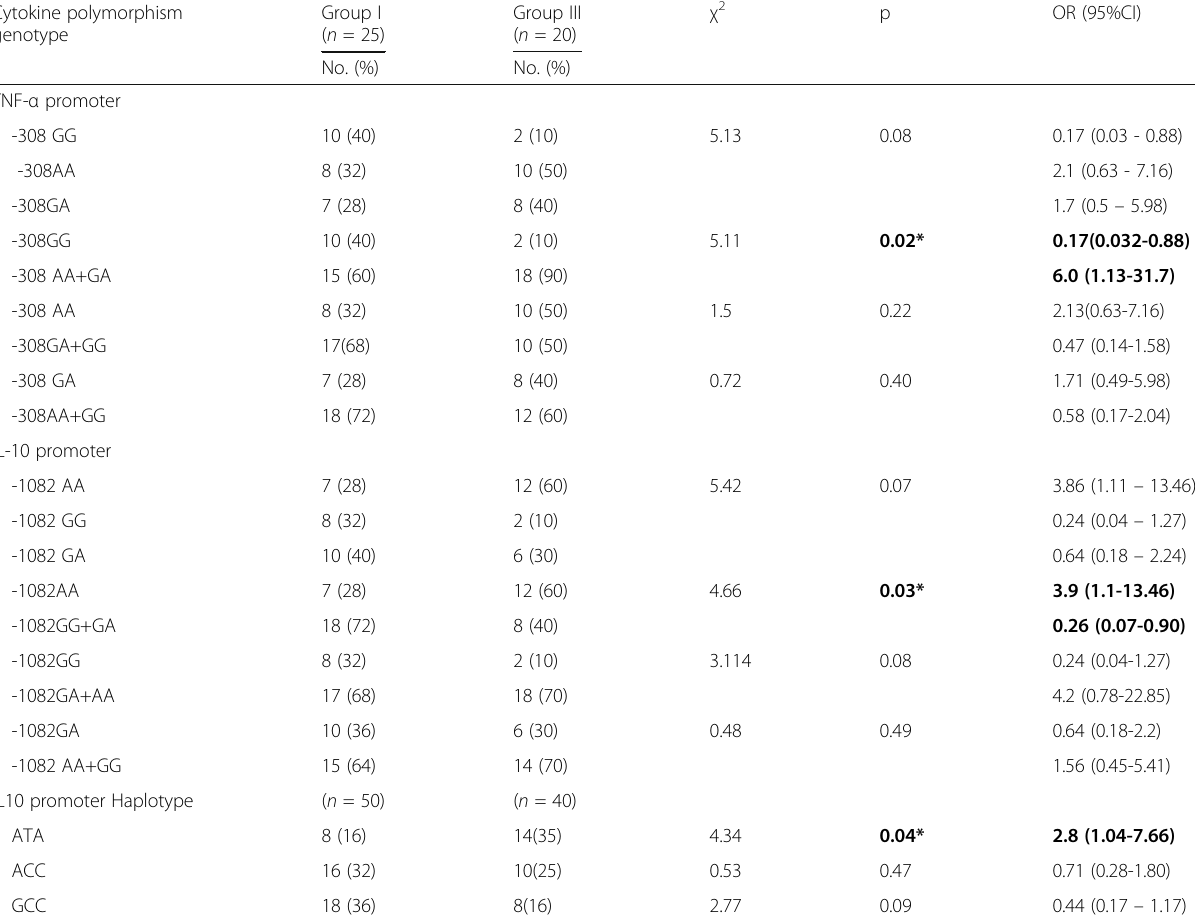
Table 5 Distribution frequency of TNF -308G>A, IL-10-1082A>G genotypes and IL-10 -1082A>G, -819 T>C and -592 G>C haplotypes in ARD (group I), and ARD+LPD (group III) patients Cytokine polymorphism